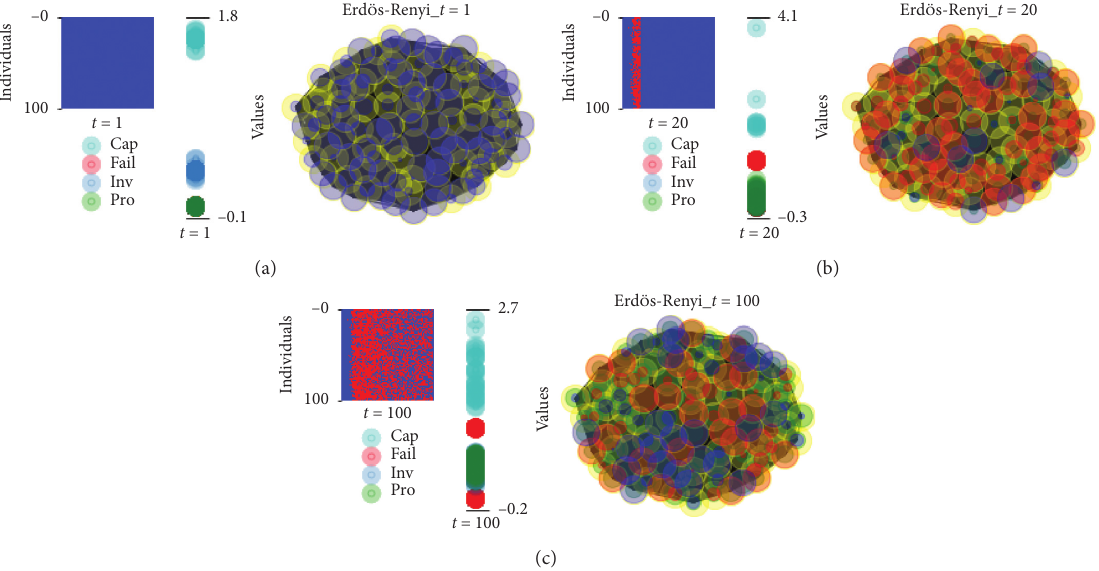
Figure 6: Protection dynamics against systemic risk with a small exploration rate. At each section, plots of the left-hand side show the matrix (horizontal axis � time step from 1 to 100, vertical axis � individuals from 0 to 100, color of the matrix � failure state between fail (red) and absence of fail (blue)). The plots of the middle show each individuals’ parameter values at the time step ( t � 100: cyan: cap � capital ( c ), red: fail � failure, blue: inv � investment ( f ), green: pro � protection potential ( p )). The plot on the right-hand side represents the individuals’ p p dynamics with a random network; node color � states (failure (red) ⟷ (blue) absence of failure, green � protection potential, yellow- � initial structure of the state without failure and